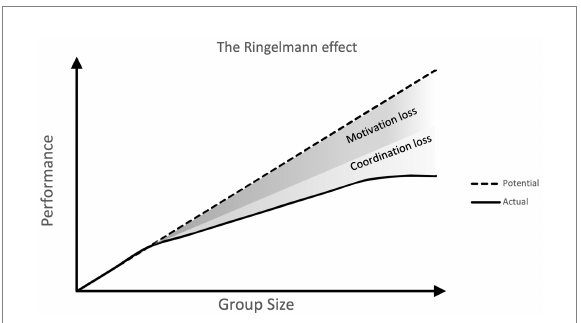
FIGURE 1 Visualization of the Ringelmann effect. As group size increases individual members become less productive. Actual performance is lower than potential performance, due to declines in coordination and